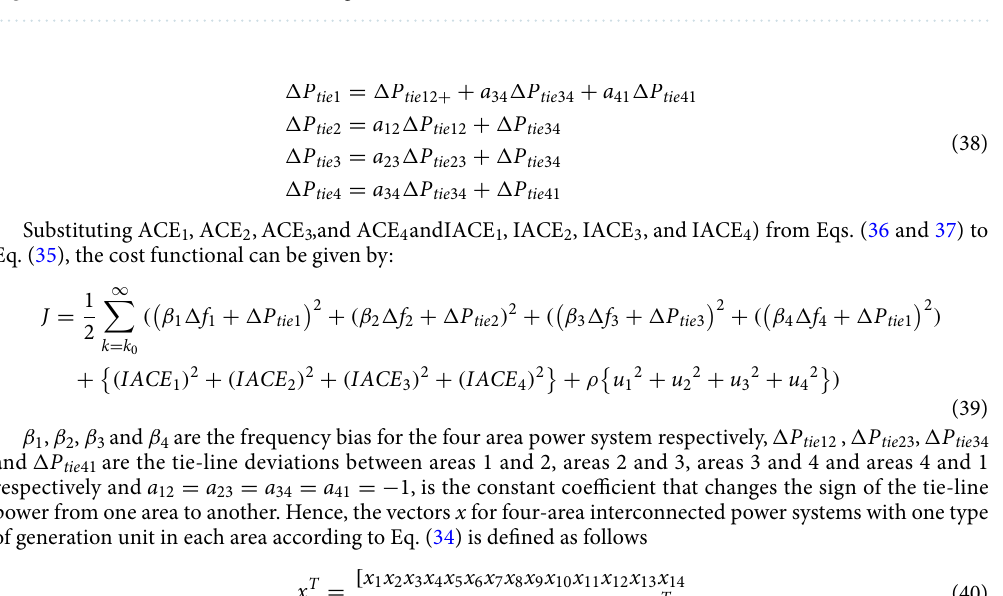
Figure 4. Flow chart of the OQAGC